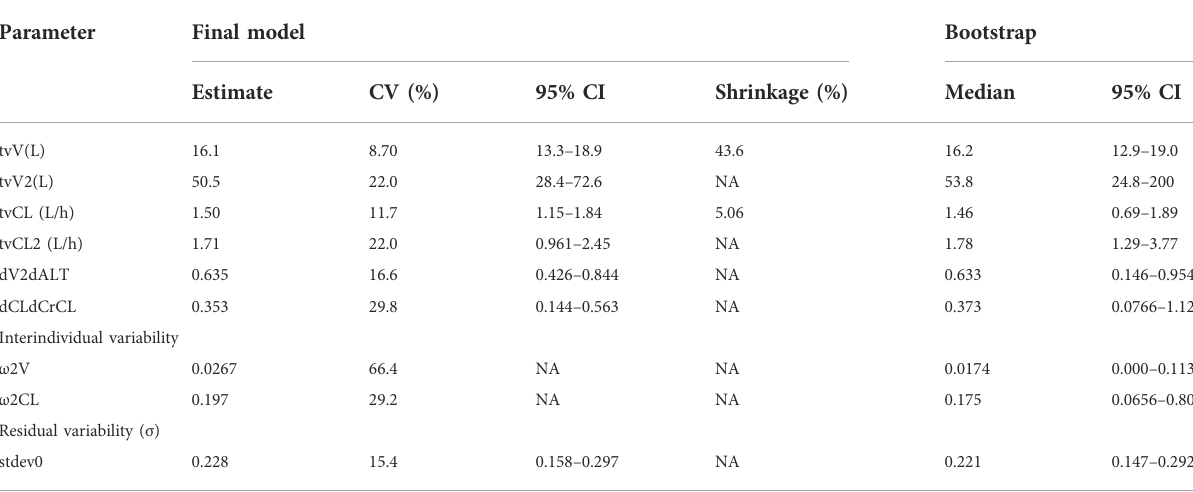
TABLE 2 Parameter estimates and bootstraps results of the fi nal population pharmacokinetic model.